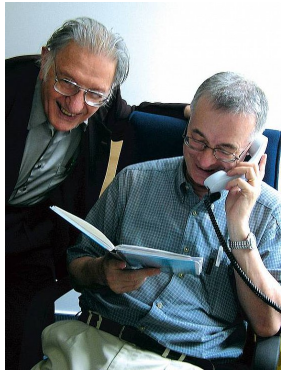
Figure 3: Abe Sklar and Jaroslav Smítal featured in the Czech newspaper Opavský a Hlučínský Deník , June 22, 2008. The 46th International Symposium on Functional Equations was held in Opava June 22–29, 2008.